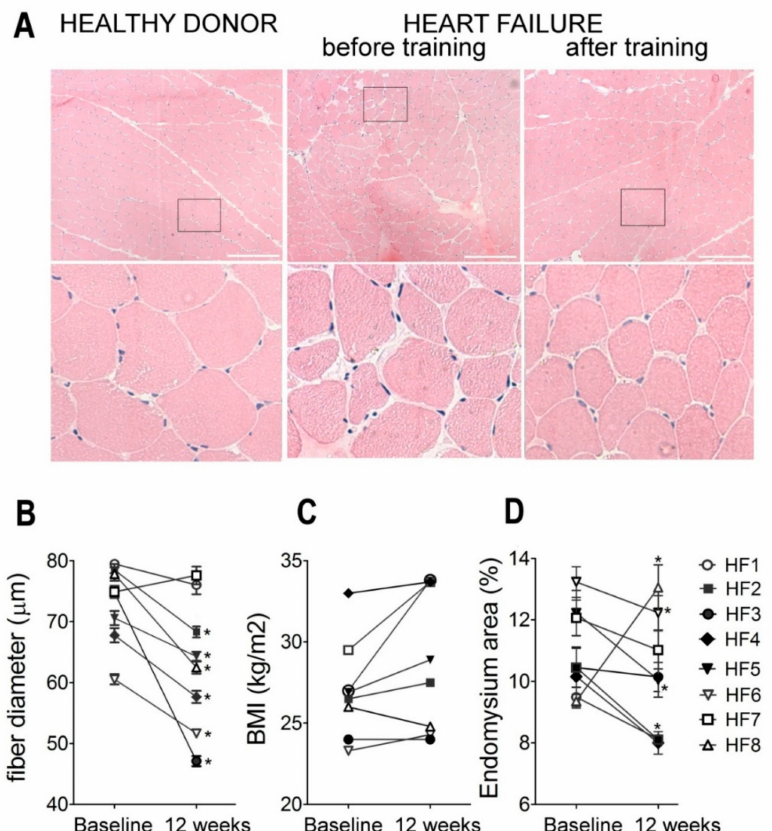
Figure 4. Skeletal muscle histological analysis before and after exercise training. ( A ) Representative histological images before and after exercise training are given for patient HF6. Images of the healthy donor are given for reference purposes. Scale bars represent 200 µ m; ( B ) skeletal muscle fiber thickness before and after training in patients with HF ( n > 60 for each experimental point; * p < 0.001; whiskers indicate min and max fiber diameter in the sample; line in the box indicates the median), ( C ) body mass index (BMI) changes after the training course in HF patients in the group; ( D ) individual data for the cross-sectional area of endomysium ( n > 50 fibers for each experimental point; * p <